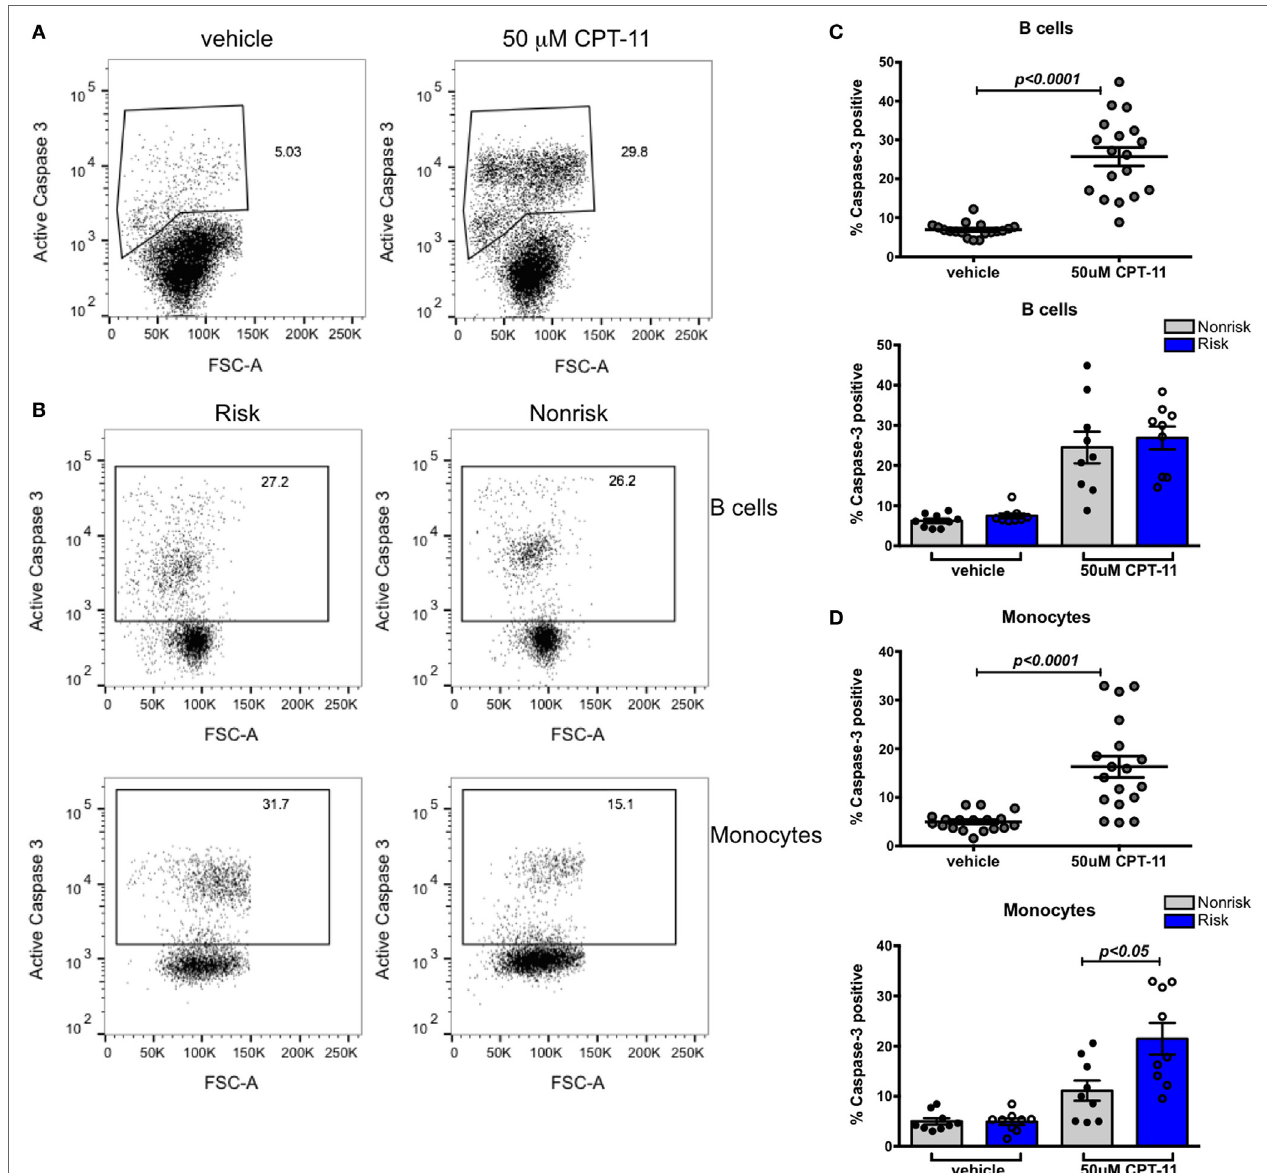
FigUre 4 | Susceptibility to apoptosis in B cells does not differ according to interferon regulatory factor 5 haplotype. Fresh peripheral blood mononuclear cells (PBMCs) were treated with 50 mM CPT-11 for 8 h, stained for CD19, CD14, viability dye, active caspase 3, and analyzed by flow cytometry. (a) Representative dot plots of vehicle and CPT-11-treated PBMCs. (B) Representative dot plots showing proportions of caspase 3 + B cells (top row) and monocytes (bottom row) in risk (left column) and non-risk (right column) haplotype subjects. (c) Proportion of apoptotic CD19 + cells shown combined (top) and separated by haplotype (bottom). (D) Apoptotic CD14 + monocytes shown combined (top) and separated by haplotype (bottom). p < 0.0001 by Wilcoxon matched-pairs signed rank test [ (c,D) , top], p = ns by Mann–Whitney test for each treatment [ (c) , bottom], p < 0.05 by Mann–Whitney test for each treatment [ (D) ,